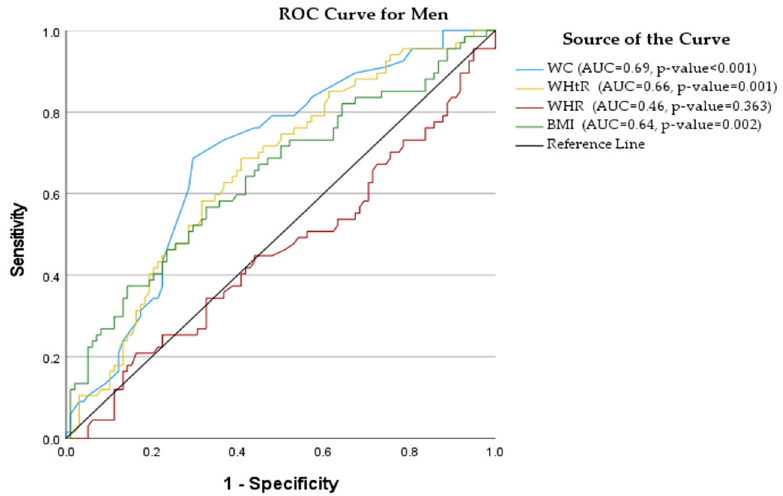
Figure 1. ROC curves for men presenting the relationship between obesity indicators and elevated SBP ( ≥ 140 mmHg).